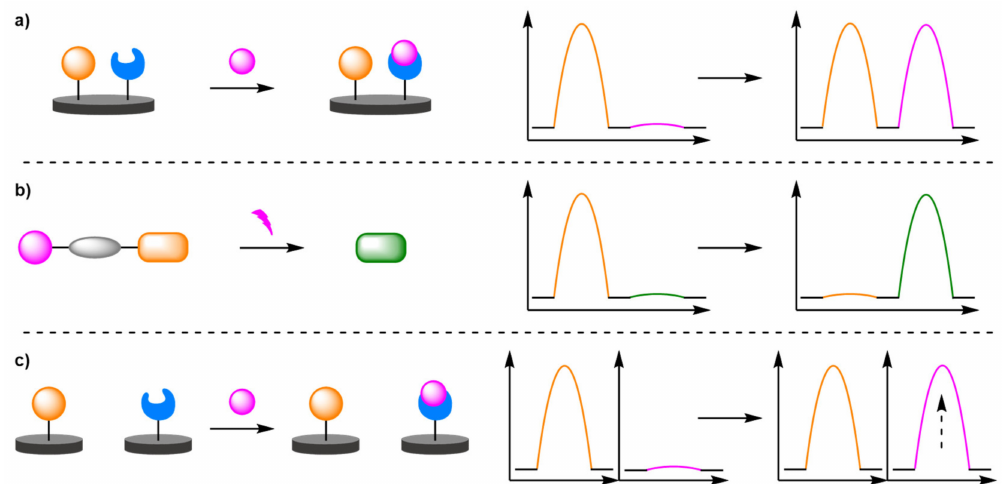
Figure 1. Overview of ratiometric electrochemical biosensors: ( a ) secondary redox-active labelling; ( b ) chemodosimeters; ( c ) dual-channel